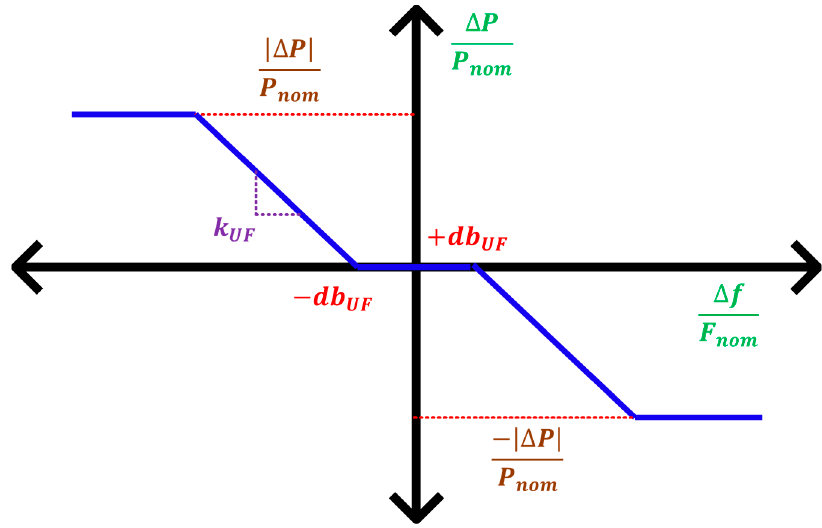
Figure 10. Classical Droop Control Method for Primary Frequency Response.